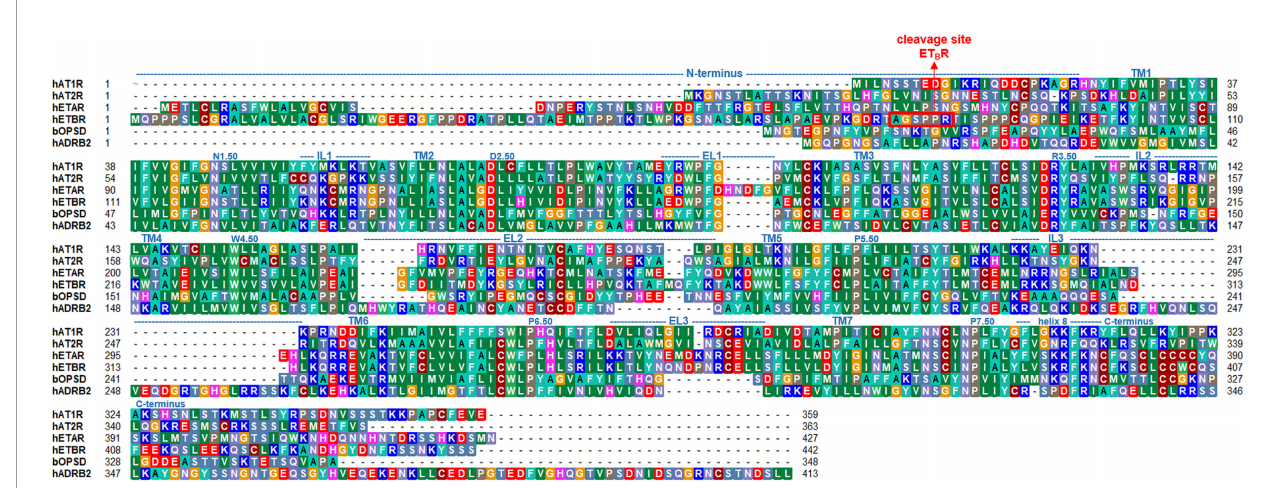
FIGURE 1 | Sequence comparison between the ATRs, ETRs, and bovine rhodopsin (bOPSD) or human b -2 adrenergic receptor (hADRB2). The length of each transmembrane helix (TM1-7) or loops (IL, intracellular loop; EL, extracellular loop) are indicated above the sequence according to an AT 1 R structure [PDB ID: 4zud (53)] but can differ slightly in other structures. The overall sequence similarity between ET A R and ET B R is approximately 63%, whereas between AT 1 R and AT 2 R ~47%. Sequence similarities between ATRs and ETRs, respectively, are around 30%. The sequences of prototypical class A GPCRs bOPSD and hADRB2 are provided additionally for comparison. The alignment was visualized using the software BioEdit (54). Speci fi c background colors re fl ect chemical properties of the amino acid side chains or the type of amino acid: black-proline; blue-positively charged; cyan/green-aromatic and hydrophobic; green- hydrophobic; red-negatively charged; gray-hydrophilic; dark red-cysteines; and